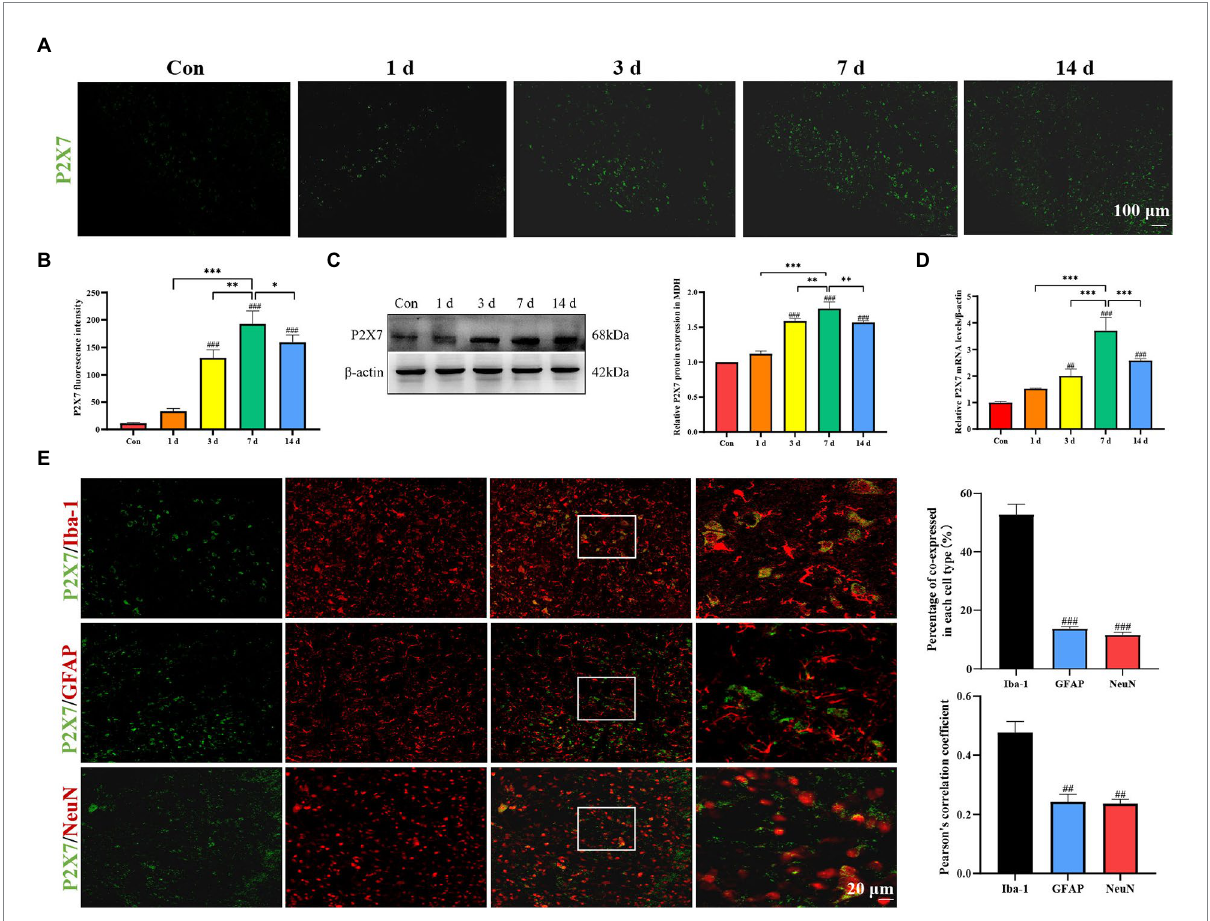
FIGURE 3 Expression of P2X7 in MDH after dental pulp exposure. (A,B) Immunofluorescence staining showed that expression of P2X7 in MDH gradually increased with a prolonged exposure time of the dental pulp. (C) Western blot analysis showed that P2X7 protein levels markedly increased compared to the control group, with the highest expression on the seventh day. (D) The mRNA levels of P2X7 increased gradually with a prolonged pulp exposure time with the highest expression on the seventh day. * p < 0.05, ** p < 0.01, *** p < 0.001 vs. 7 days group, ## p < 0.01, ### p < 0.001 vs. control. (E) Double immunofluorescence staining showed that P2X7 was mainly located in microglia, rather than in astrocytes nor neurons. ## p < 0.01, ### p < 0.001 vs. Iba-1